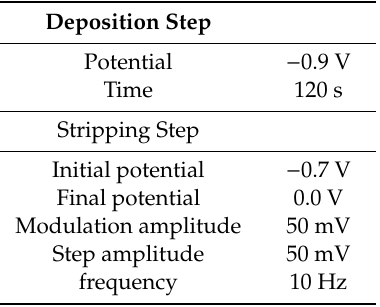
Figure 4. Heavy metal (HM) ion during (1) deposition and (2) stripping step on screen-printed gold electrode (SPGE) connected to potentiostat read-out circuit component (PRCC). RE, WE, and CE are reference electrode, working electrode, and counter electrode, respectively. Table 2. Experimental parameters.